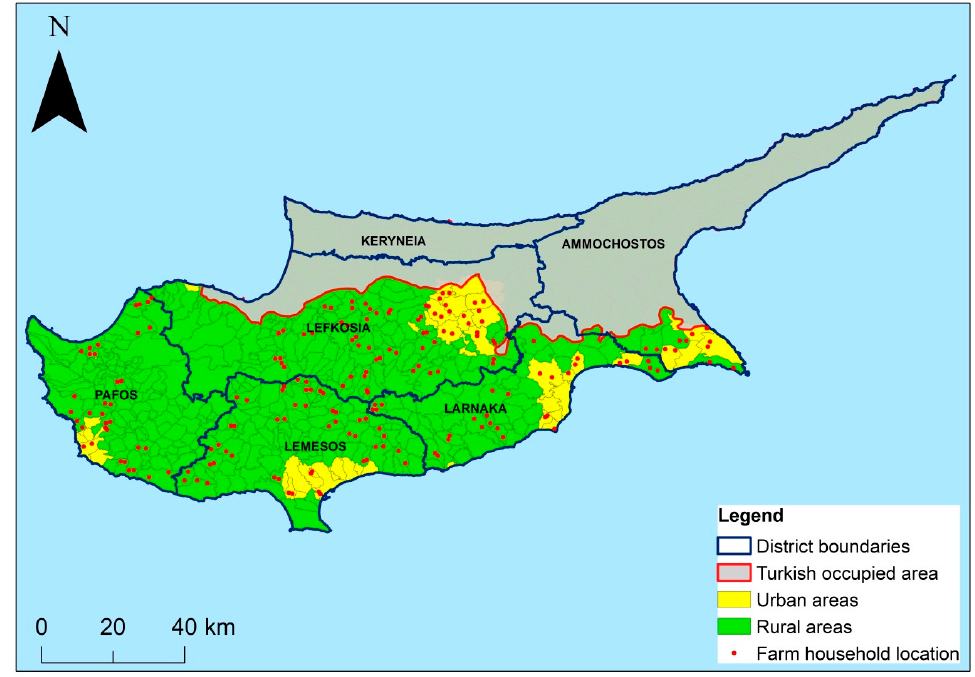
Figure 2. Distribution of surveyed farm households by district and rural/urban areas.